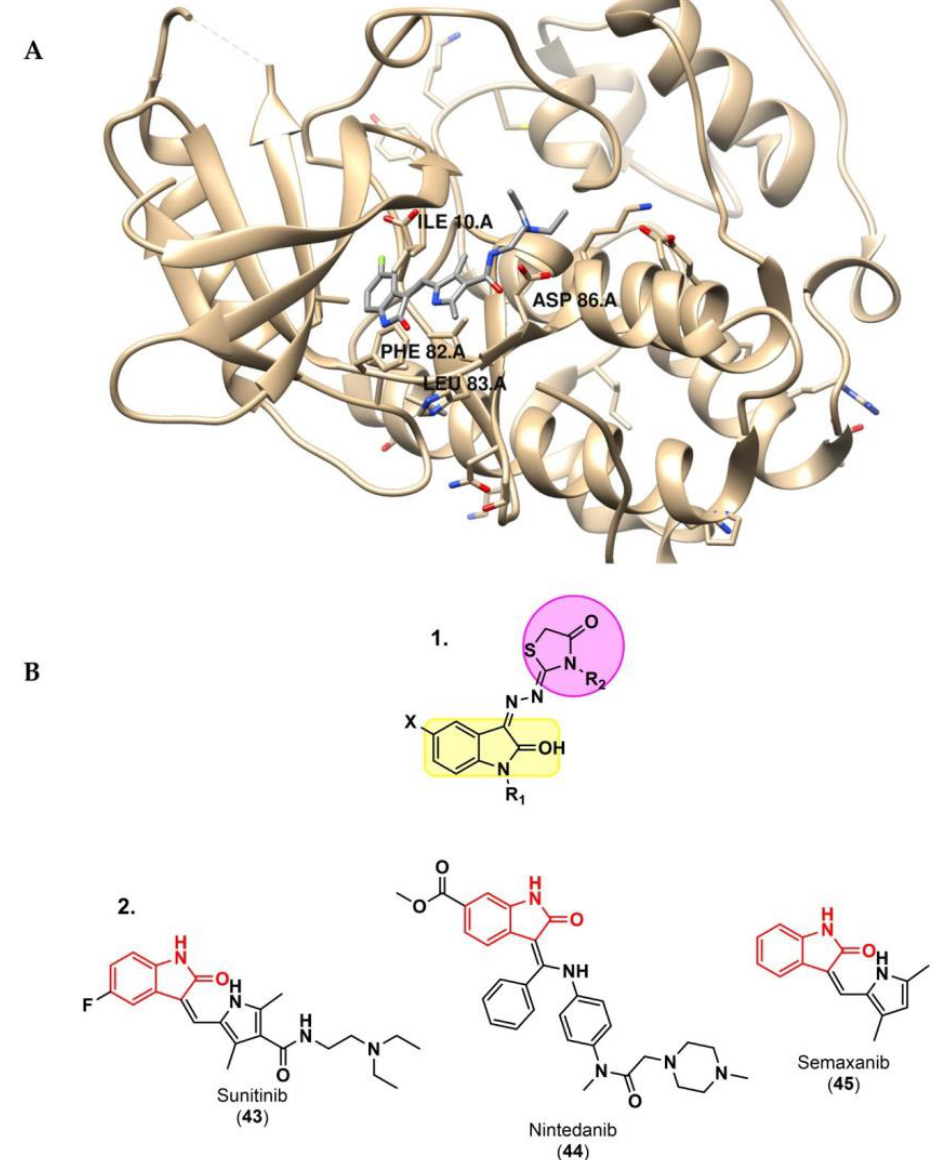
Figure 7. ( A ) 3D interactions of sunitinib with CDK2 (PDB code: 3Ti1) using UCSF Chimera [58,84]. ( B ) 1. Structure of the designed hybridized molecules. 2. 2-indolinone pharmacophore motifs in CDK2 inhibitor commercially marketed drugs [58,84]. CD73, a glycosylphosphatidylinositol (GPI)-linked cell surface enzyme, has